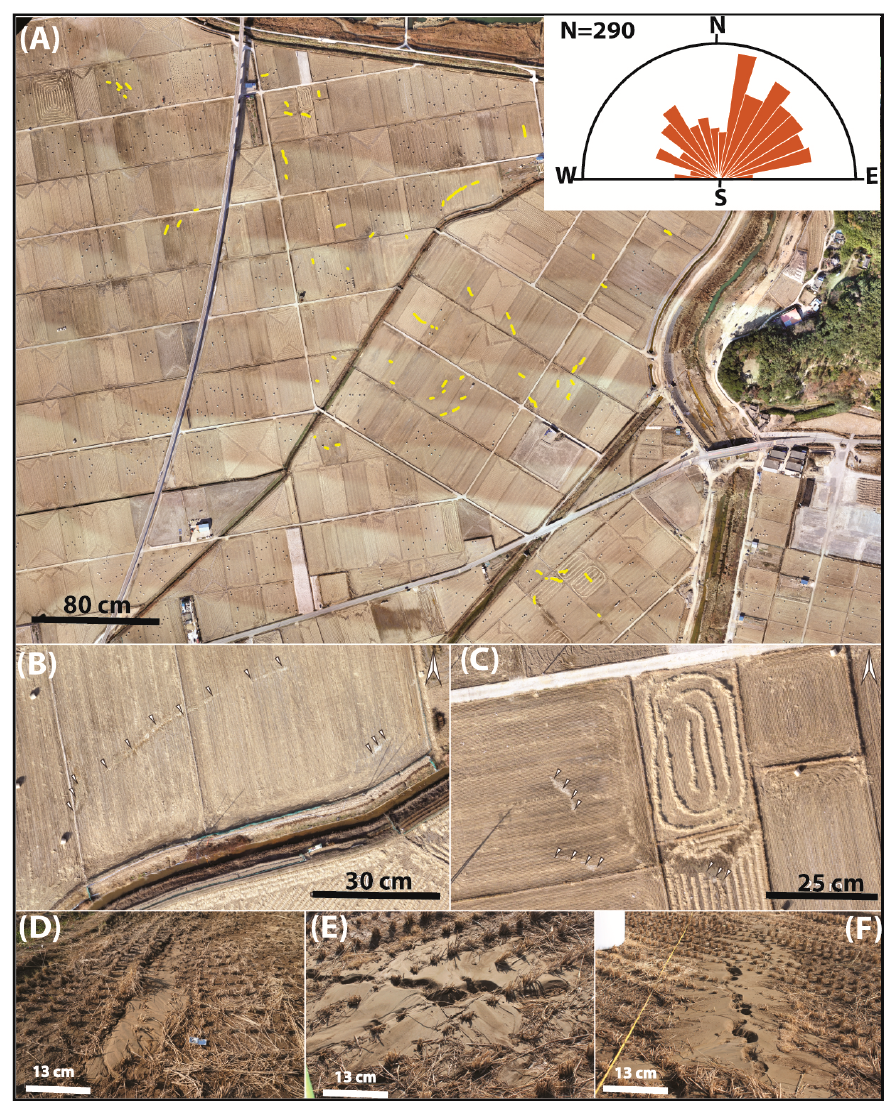
Figure 4. Unmanned Air Vehicle (UAV) images and field photographs showing typical liquefaction features observed during the Pohang earthquake. ( A – C ) UAV images showing the distribution of sand boils and rose diagram showing two preferential trends: NNE ~SSW and NE-SW. ( D – F ) Field photographs showing typical isolated and series of sand boils observed in the agricultural field.